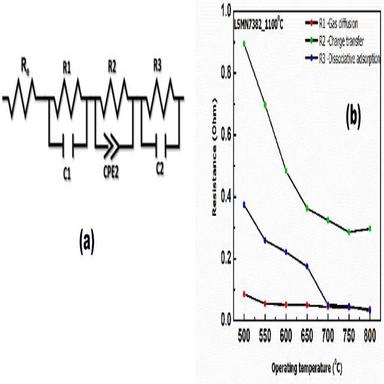
(a) Equivalent circuit representation of cathode electrolyte interface for the investigated cathode compositions. (b) R1, R2 and R3 values of LSMN7382 interface with LSGMN10 electrolyte with respect to operating temperature.